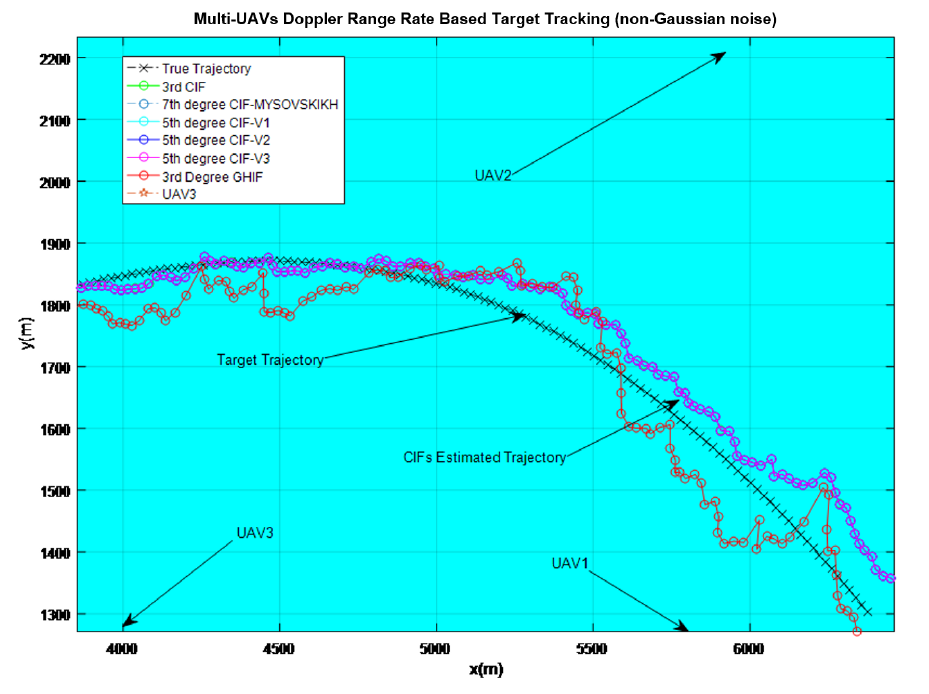
Figure 4. Target tracking estimation using 3 rd degree CIF, 5 th degree CIF-V1-V2-V3 and 7 th -degree Cubature Information filters (CIFs) compared to 3 rd -degree Gauss–Hermite information filter. UAV1, UAV2 and UAV3 are delivering Doppler measurement information to the control center for global information fusion.